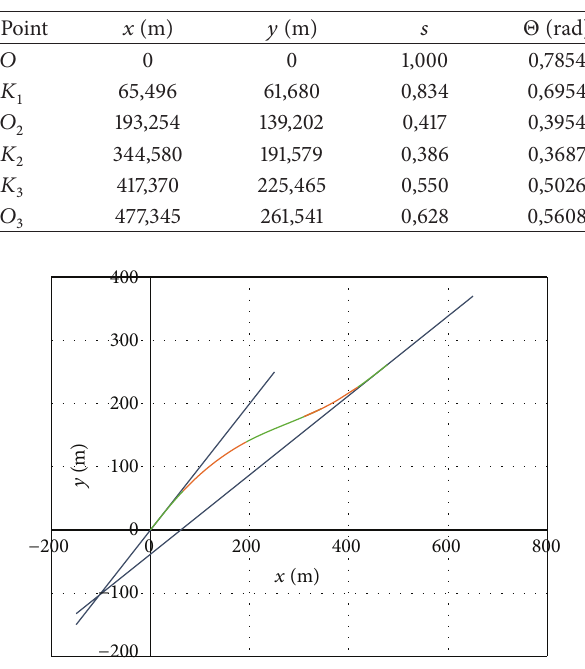
Figure 8: Visualization of the designed geometric system (Example